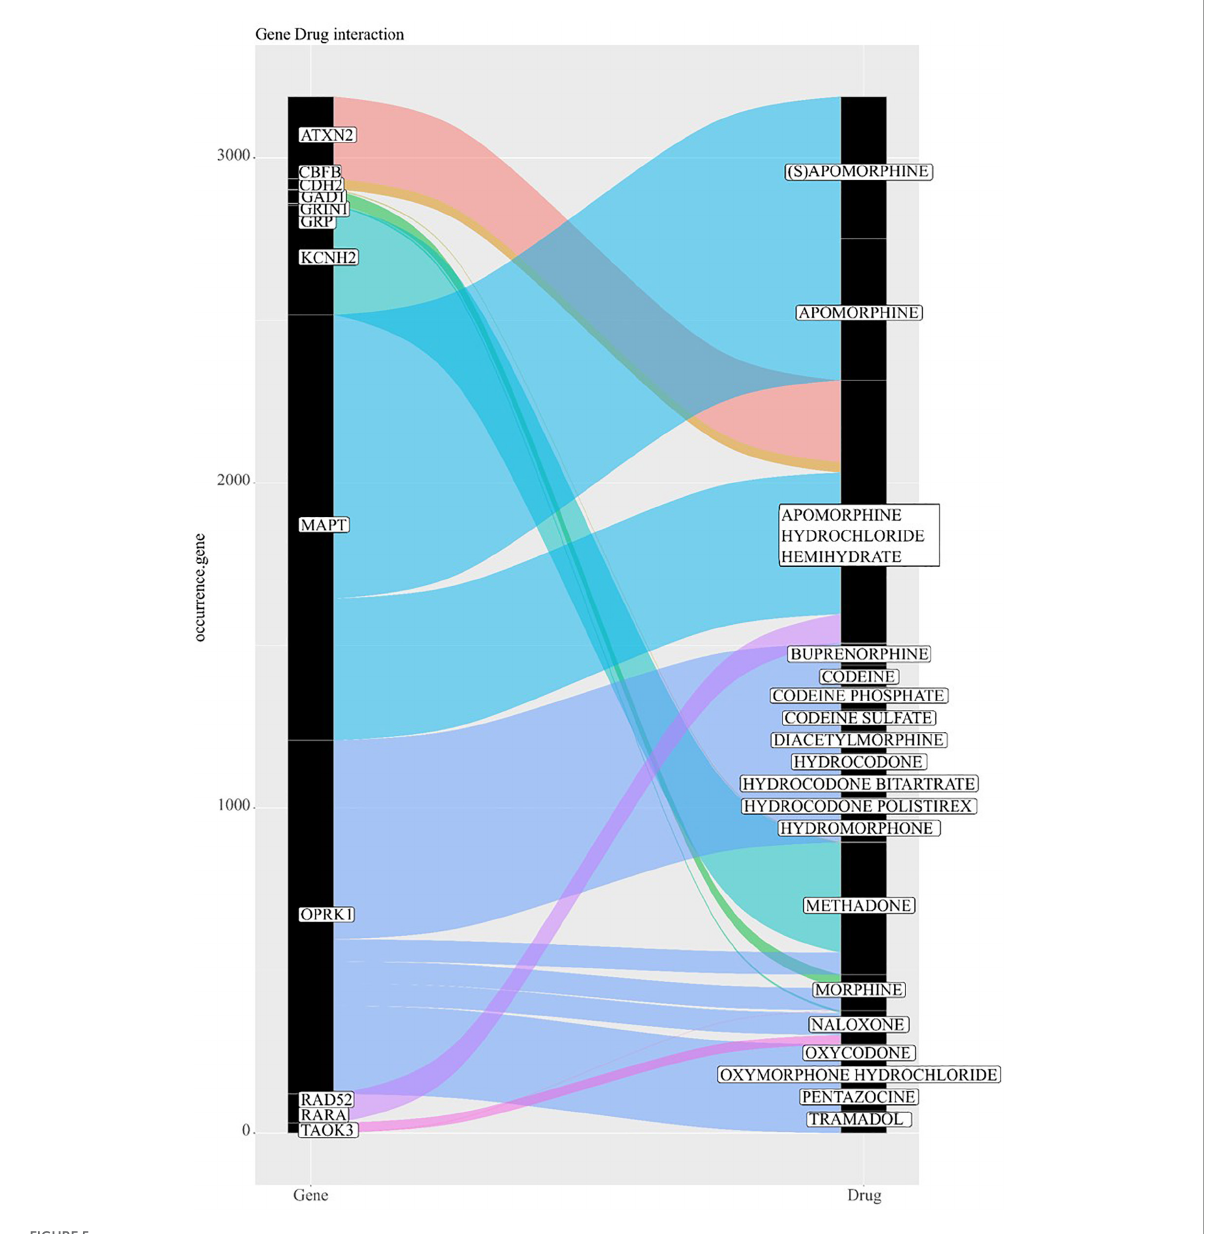
FIGURE5 Gene-drug interactions with opioids. The figure shows all genes that interact with 15 selected opioids. OPRK1 interacts with most opioid-related drugs.